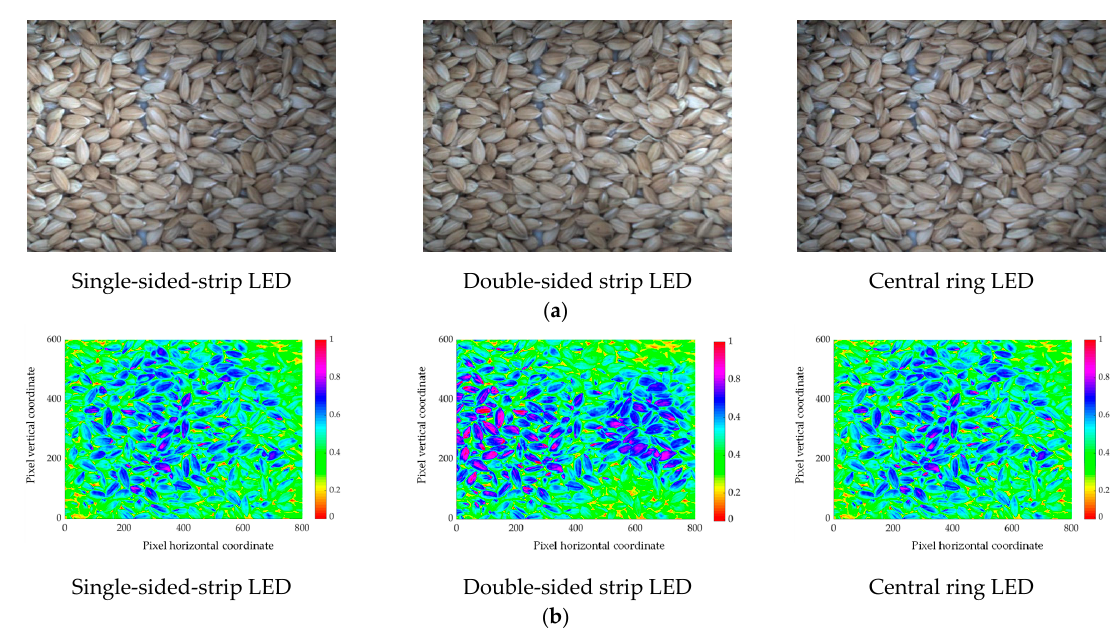
Figure 9. The grain images and the V component distribution under different light irradiations. ( a ) Grain images captured under different light irradiations; ( b ) the distribution of the V component. To further quantify and analyze the effect of light irradiation on the image brightness, the V value of each pixel in the image was counted. The V value distribution histogram under light irradiation is shown in Figure 10. The higher the proportion of lightness around the median value ( V = 0.5) and the smaller the coefficient of variation of the overall lightness, the more suitable it is for subsequent image processing. The V value percentage in a range of [0.30, 0.70], [0.25, 0.75], and [0.20, 0.80] and the coefficient of variation of the V value were calculated and the results are shown in Table 4.